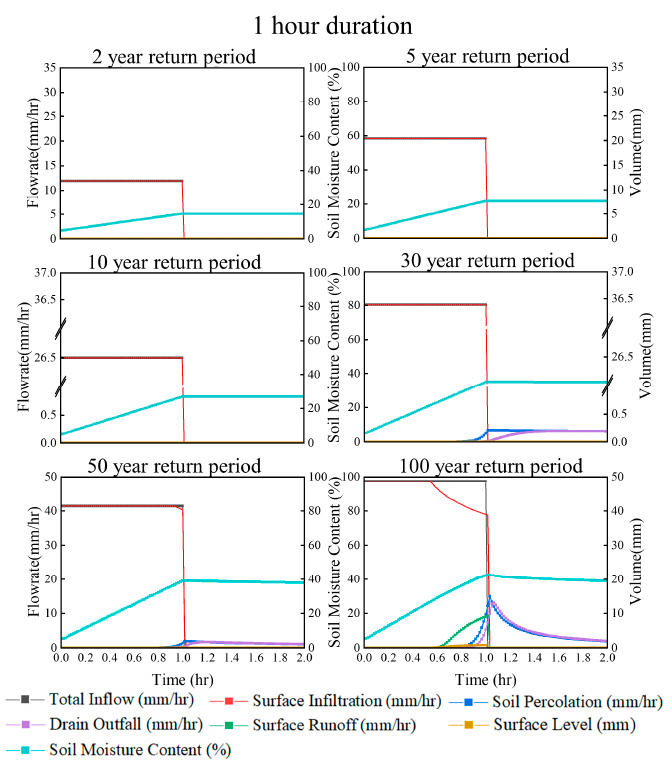
Figure 10. SWMM detailed reports on green roofs in 1 h rainfall events.